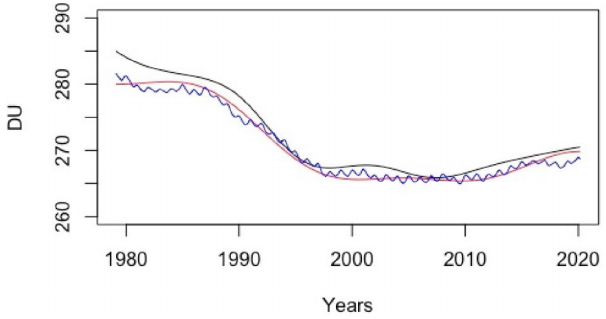
Figure 11. The residual Trend EAWD returned by the EAWD tech- nique (red curve), the trend of the original signal obtained from a moving window (blue curve) with a size fixed at 125 (i.e. 10.4 years), and the residual returned by the EEMD technique (black curve).